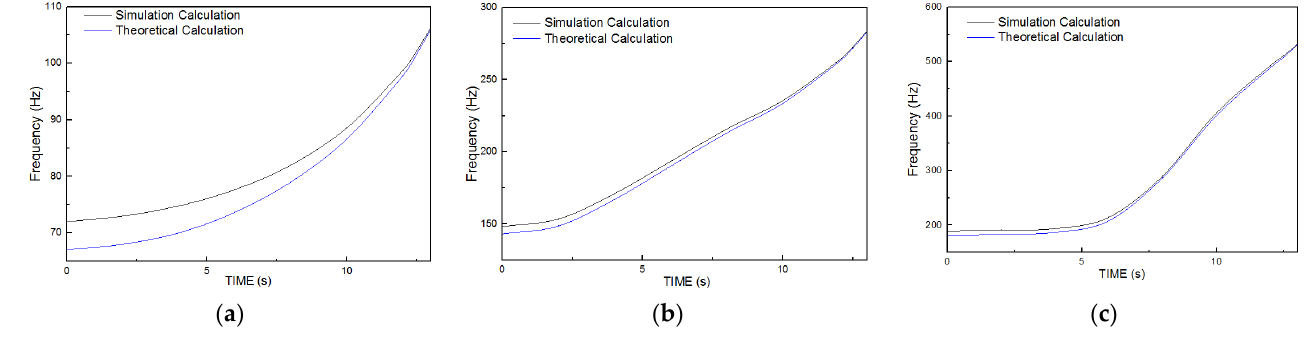
Figure 15. Working time-varying first-order natural frequency of the rocket engine shell, ( a ) 1st Or- der natural frequency, ( b ) 2nd Order natural frequency ( c ) 3rd Order natural frequency.